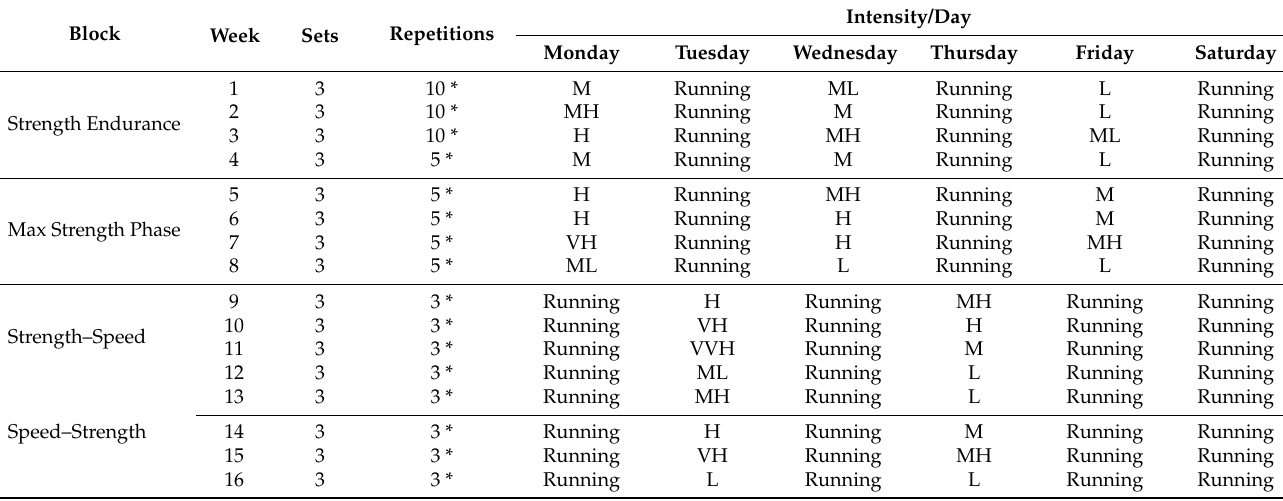
Table 1. Training program